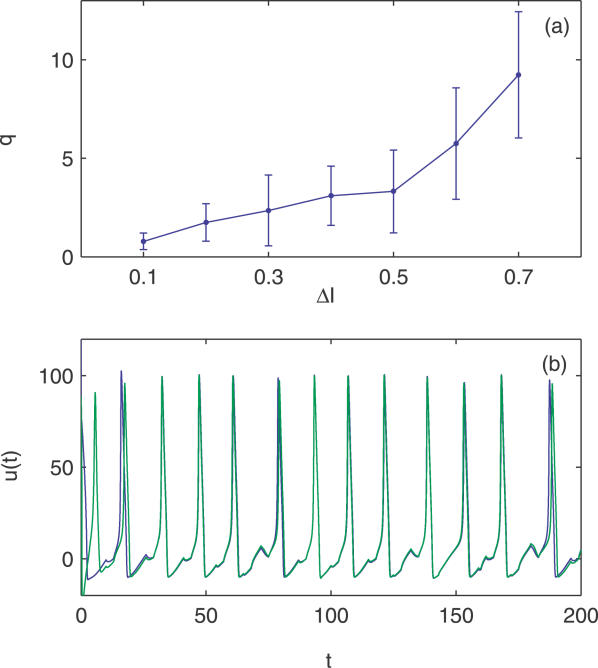
Robustness of the Mechanism with Parameter Mismatch on I
0 in the HH Neuron Model(A) The relationship between the parameter mismatch ΔI and the synchronization error q.(B) A typical numerical result of the systems with ΔI
 = 0.5.